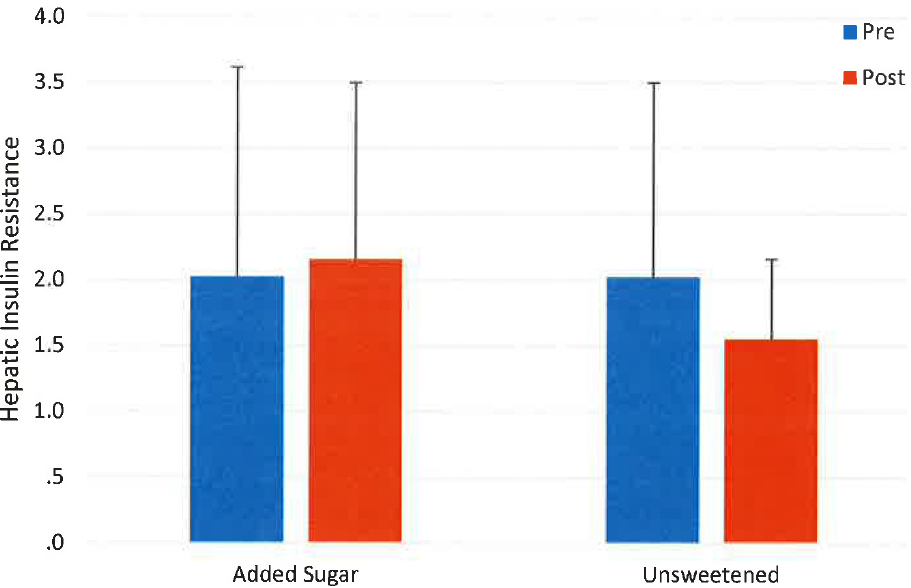
Figure 3. Change in hepatic insulin resistance after ten weeks’ consumption of low-fat milk sweetened with a sugar ( n = 72) or unsweetened ( n = 21); interaction p > 0.05.